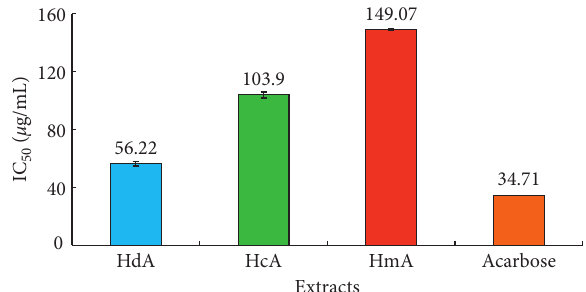
Figure 6: IC 50 of α -amylase inhibitory activity of Hibiscus deflersii (HdA), H. micranthus (HmA), and H. calyphyllus (HcA) aqueous extracts and standard